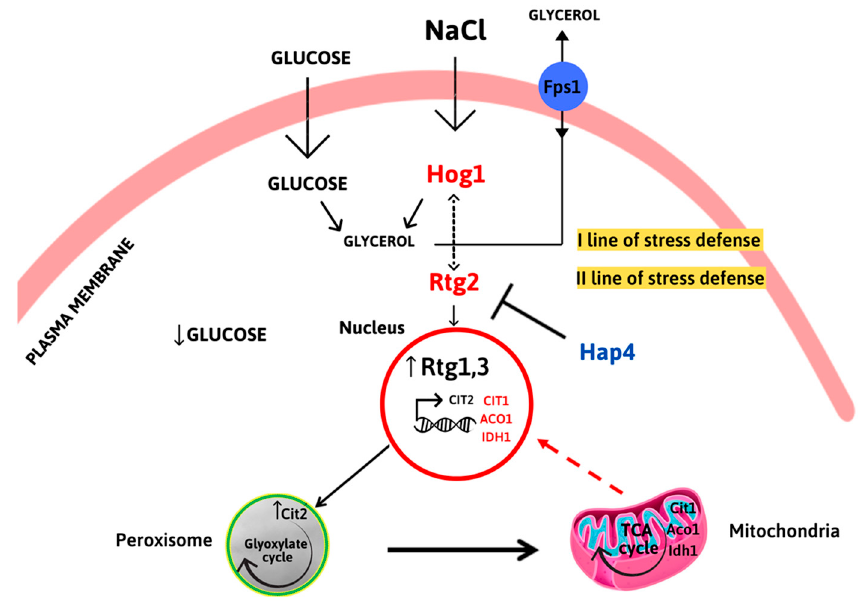
Figure 6. Interplay between HAP4 and RTG2 in osmoadaptation.